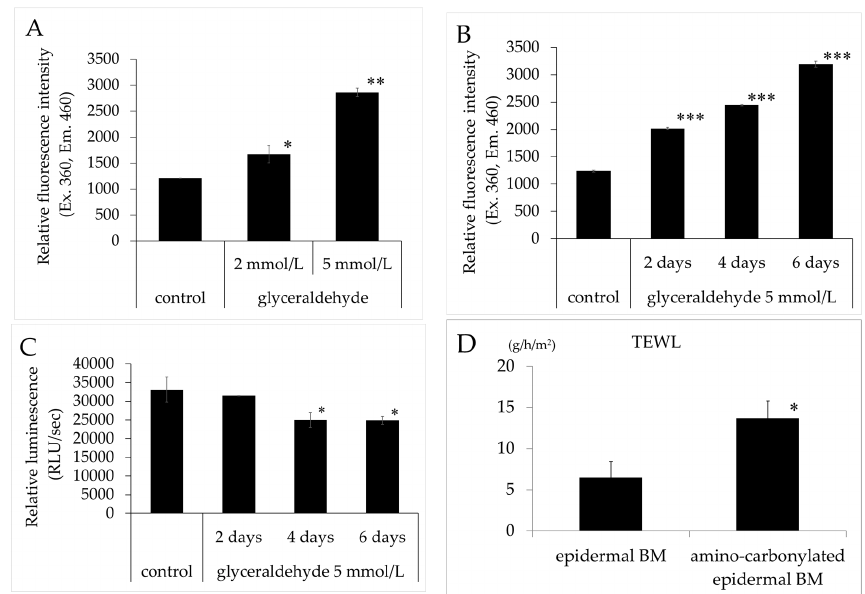
Figure 1. ( A,B ) Effects of glyceraldehyde on the relative fluorescence intensity of epidermal BM. Relative fluorescence intensity (excitation/emission, 360/460 nm) was compared between epidermal BM treated with glyceraldehyde (A, 2 and 5 mmol/L for 4 days; B, 5 mmol/L for 2, 4, and 6 days) and untreated epidermal BM (control). ( C ) ATP levels in human keratinocyte cultured on epidermal BM treated with 5 mmol/L glyceraldehyde (for 2, 4, and 6 days) and untreated epidermal BM. Results are expressed as mean ± standard deviation of three experiments. * p < 0.05 vs. control, ** p < 0.01 vs. control, *** p < 0.001 vs. control. ( D ) Effects of amino carbonylation of the epidermal BM on TEWL in the 3D model of human keratinocyte. The 3D model was cultured on epidermal BM treated with glyceraldehyde (5 mmol/L) for 4 days. Fold changes in TEWL levels are expressed as mean ± standard deviation of three experiments. * p < 0.05 vs. epidermal BM.